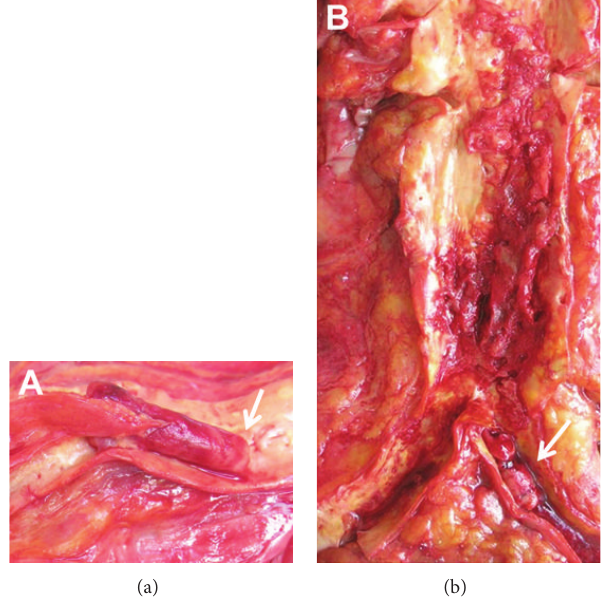
Figure2:Picturestakenafterautopsyoftherightcarotidbifurcation (a) with occluding thrombus in both branches. Please note the typical lines of Zahn at the arterial thrombus as a sign of continuing thrombus formation (arrow). The infrarenal aorta (b) shows multi- ple ulcerated arteriosclerotic plaques with mural thrombus luminal occlusion of the left common iliac artery